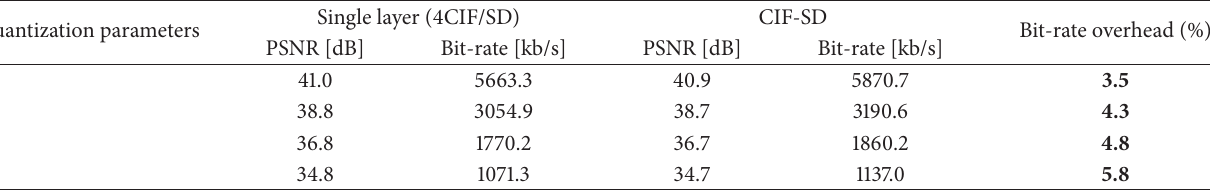
Table 2: Three-layer (CIF-SD) spatial SVC coding versus single layer (4CIF/SD) coding (“ SOCCER ” video sequence, 30 fps, 300 frames, GOP size is 16).